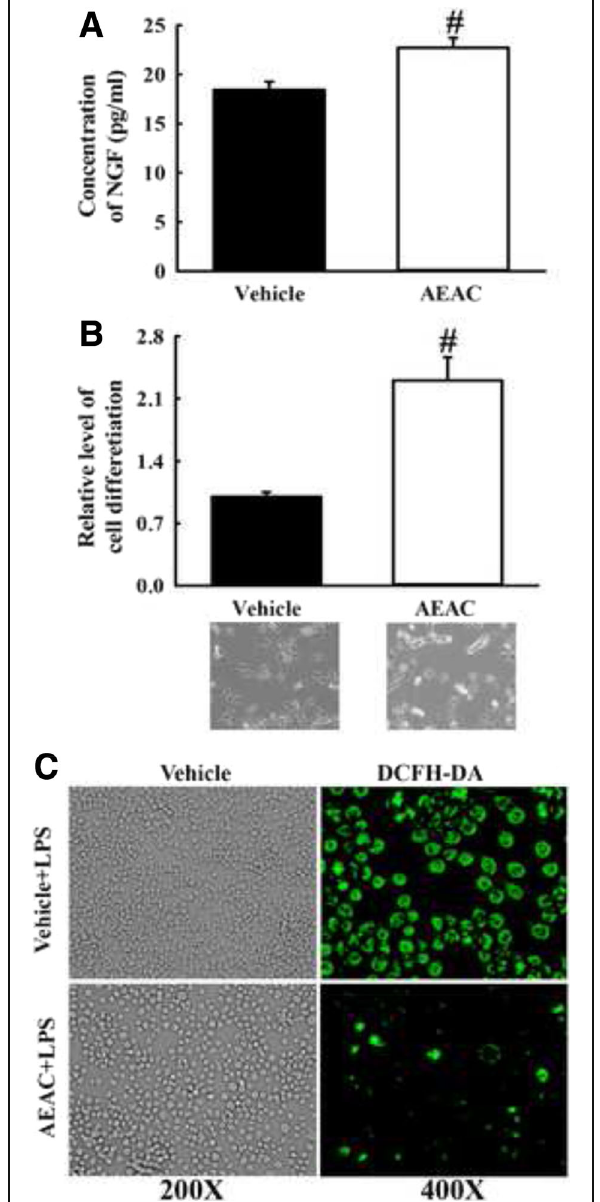
Fig. 2 NGF stimulation capacity and anti-oxidant activity of AEAC in neuronal cells. a NGF concentration in the supernatant collected from each group was measured using an anti-NGF ELISA kit NGF. b Conditional medium (CM) was collected from B35 cells stimulated with AEAC for 24 h, then transferred to undifferentiated PC12 cells. After 24 h the cell morphology was observed at 200× using a microscope. The length of PC12 cells was measured using Leica Application Suite (Leica Microsystems). Values shown represent the means ± SD of three experiments. # , P < 0.05 compared to the Vehicle treated group. c Determination of intracellular ROS production. After DCFH-DA treatment, green fluorescence in cells of subset groups was observed using a fluorescent microscope (Eclipse TX100, Nikon, Tokyo, Japan). BV-2 cells in each square of a 200× magnification image (left column) were further examined under 400× magnification (right column)